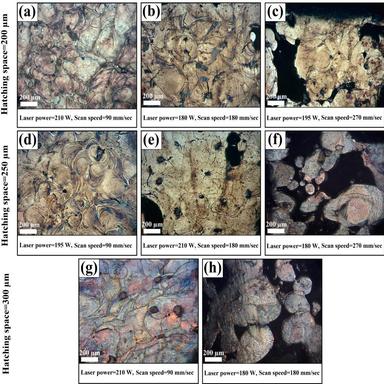
Effects of hatch space at three different levels of (a-c) 200, (d-f) 250, and (g, h) 300 µm at a constant layer thickness of ~ 40 µm on the soundness and integrity of LPBF deposited nanocomposite structures by varying the laser printing power in the range of 180–210 W and scan speed in the field of 90–270 mm/sec.